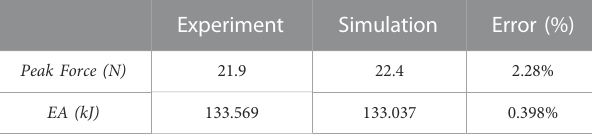
TABLE 2 Differences between experiment and FE